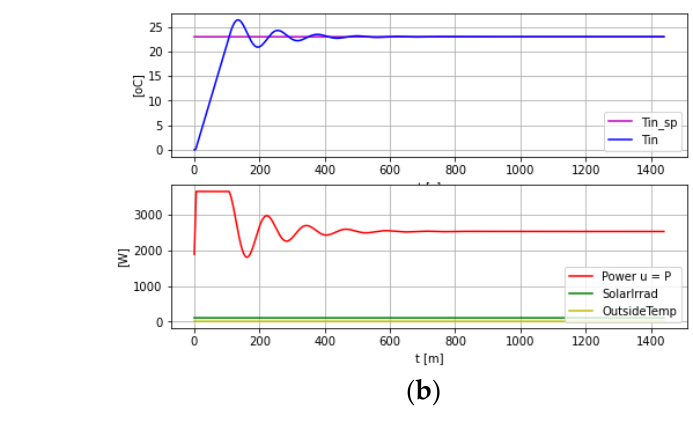
Figure 9. ( a ) ON/OFF control output; ( b ) PI control